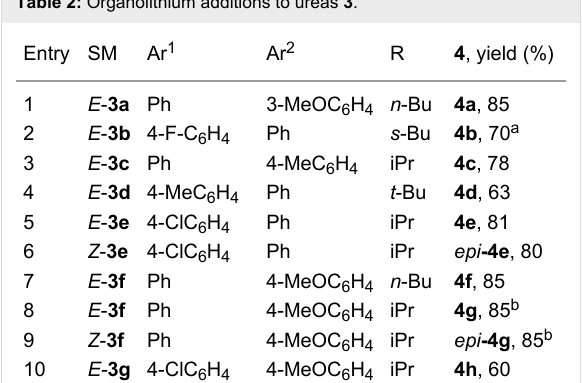
Table 2: Organolithium additions to ureas 3